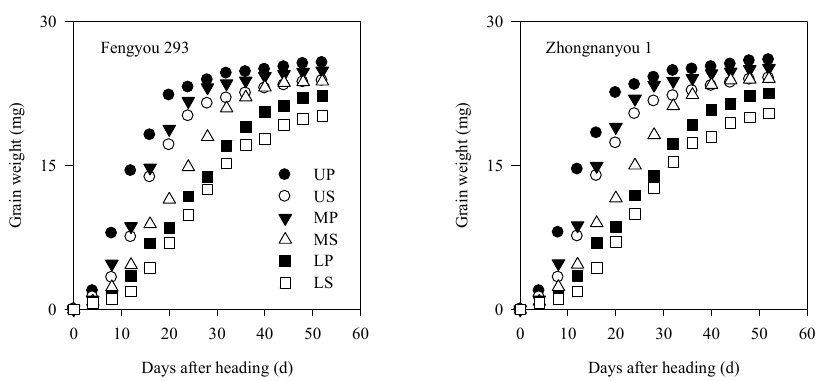
Figure 4. Dynamics in grain − fi lling process of Yongyou 2640 ( a ), Yongyou 1640 ( b ), Yangjing 4227 ( c ), Zhendao 14 ( d ), Fengyou 293 ( e ), and Zhongnanyou 1 ( d ). UP, upper primary branches; US, upper secondary branches; MP, middle primary branches; MS, middle secondary branches; LP, lower primary branches; LS, lower secondary branches.